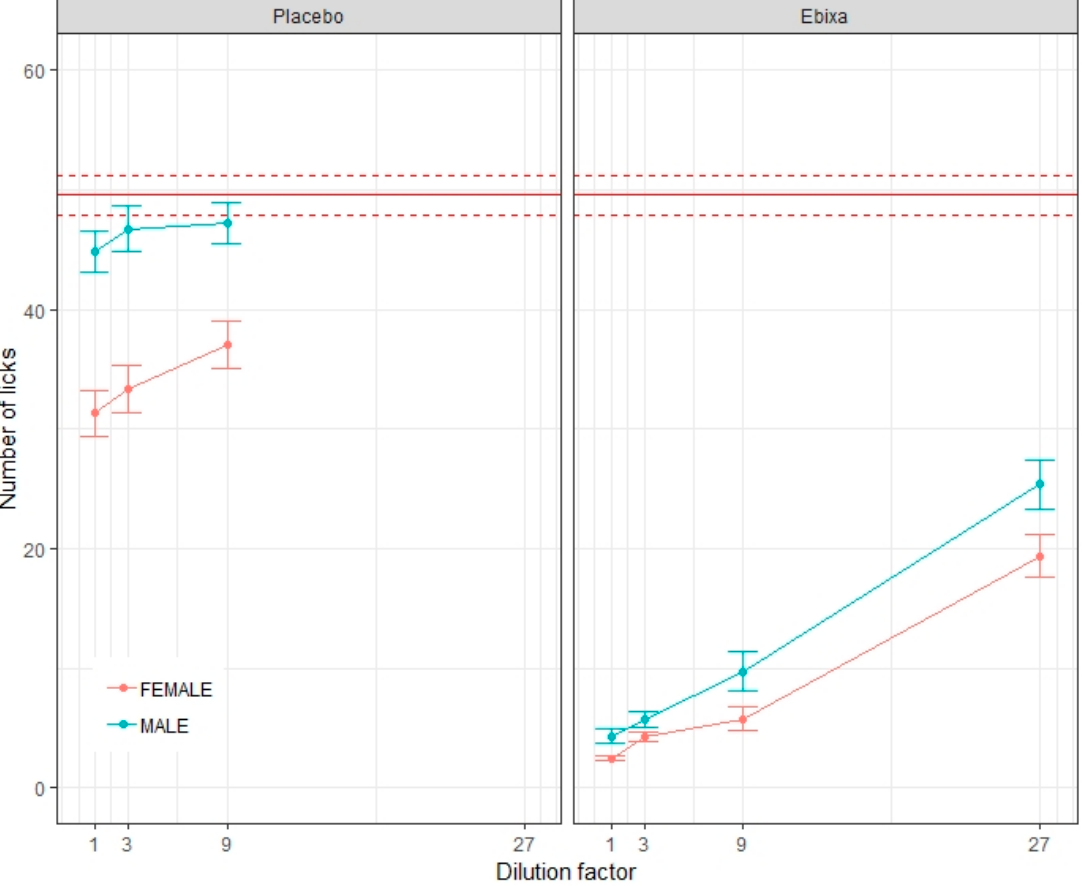
Figure 3. The aversiveness of test solutions for male and female rats. The average lick number for each dilution of placebo and original oral solution of memantine (Ebixa ® ) for male and female rats ± Standard Error of the Mean (SEM), with the average lick number of water shown as a solid red line ± SEM.